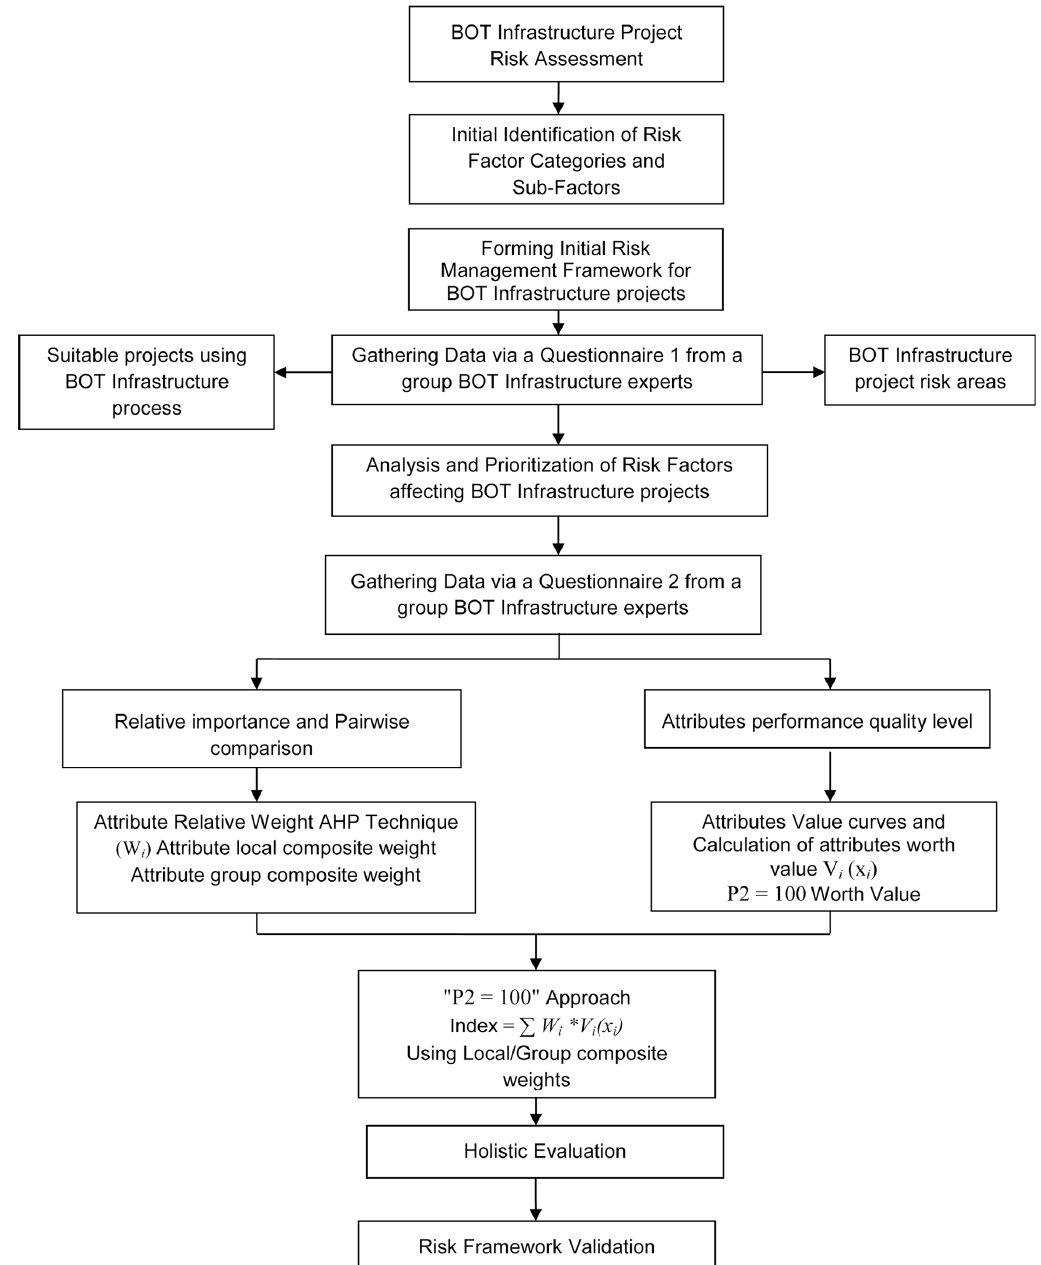
Fig. 1. Study methodology flow